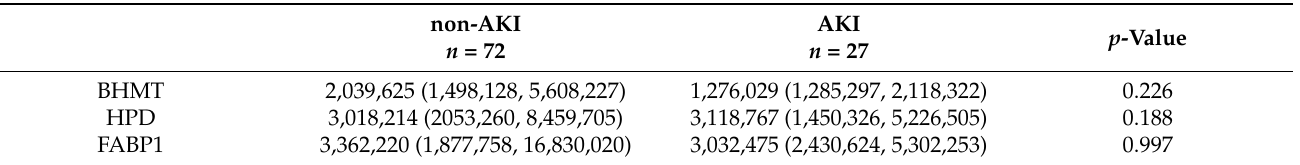
Table 5. Comparison between plasma abundance of upregulated intracellular renal proteins associ- ated with the EoT group and acute kidney injury development presented as median